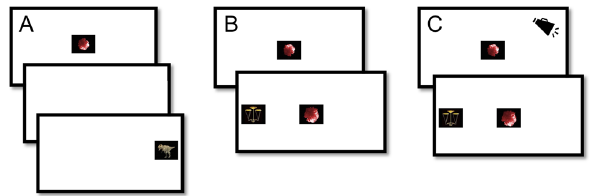
Figure 1. Overview of the eye-tracking task. The central stimulus was presented during a variable interval ranging from 800 to 1700 ms. In the gap condition ( A ), the central stimulus was extinguished before the onset of the peripheral stimulus during a period ranging from 120 to 200 ms. In the uncued overlap condition ( B ), the central stimulus remained on screen after the onset of the peripheral stimulus. In the cued overlap condition ( C ), auditory alerting cues were presented at variable time intervals ranging between 500 and 0 ms before the onset of the peripheral stimulus on 50% of the overlap trials. Participants completed 60 trials (20 gap, 20 uncued overlap, 20 cued